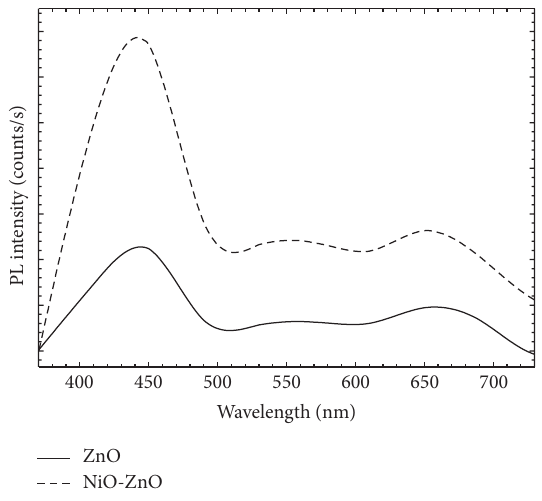
Figure 5: Photoluminescence spectra of the ZnO and NiO-ZnO